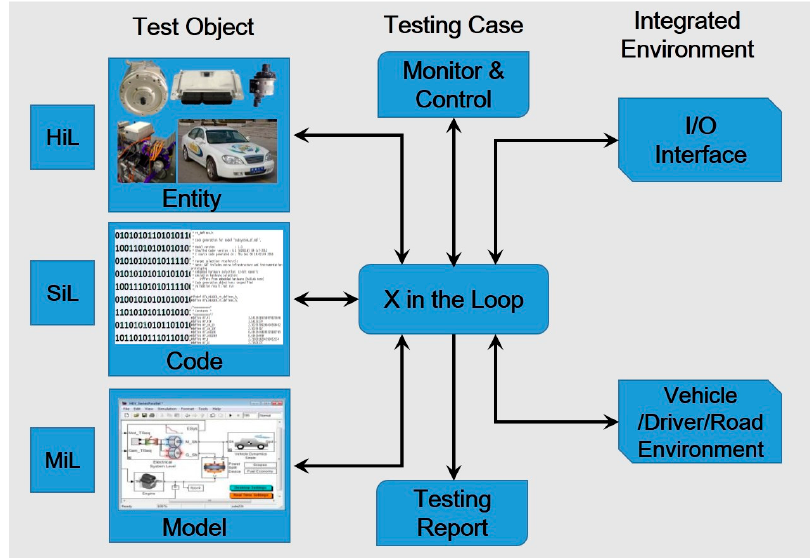
Figure 2. Definition of X-in-the-Loop.